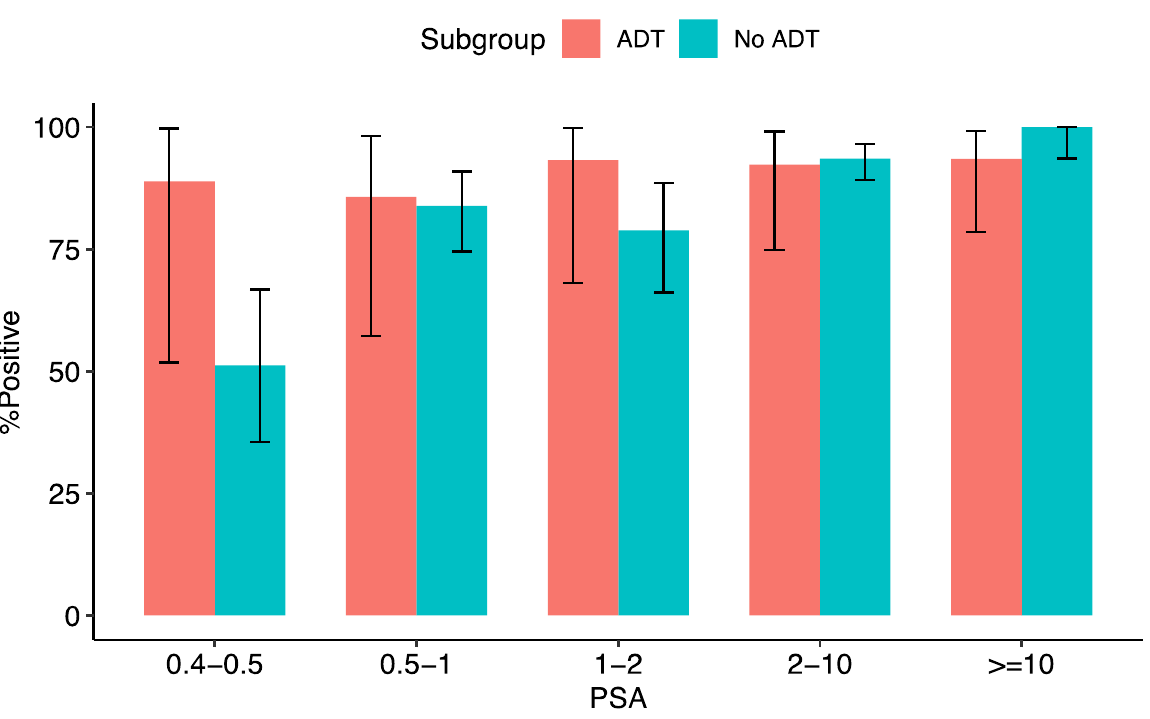
Figure 1. The proportion of positive scans in different PSA subgroups in patients with/without ongoing ADT at the time of PET/CT. Error bars represent 95% confidence interval.